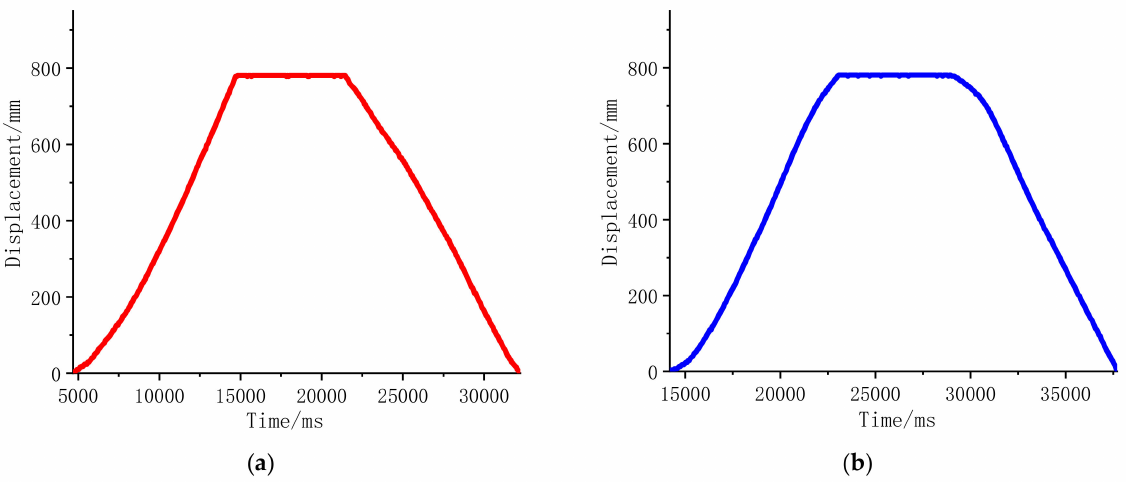
Figure 21. Comparison curve of cylinder displacement under different modes. ( a ) Cylinder displace- ment under constant speed; ( b ) cylinder displacement under variable speed.